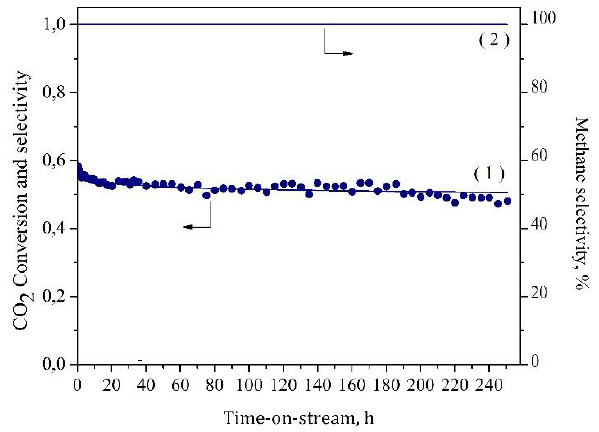
Figure 6. Long-term stability test for the 20% Ni/ZrO 2-COP catalyst. (1) 20% Ni/ZrO 2-COP . (2) Methane selectivity. Reaction conditions: 400 °C, 0.1 MPa, catalyst 0.1 g, GHSV: 43,500 mL/(h g Cat ).